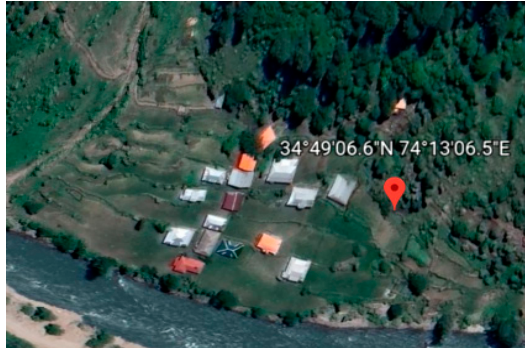
Figure 1. An aerial view of the selected location .